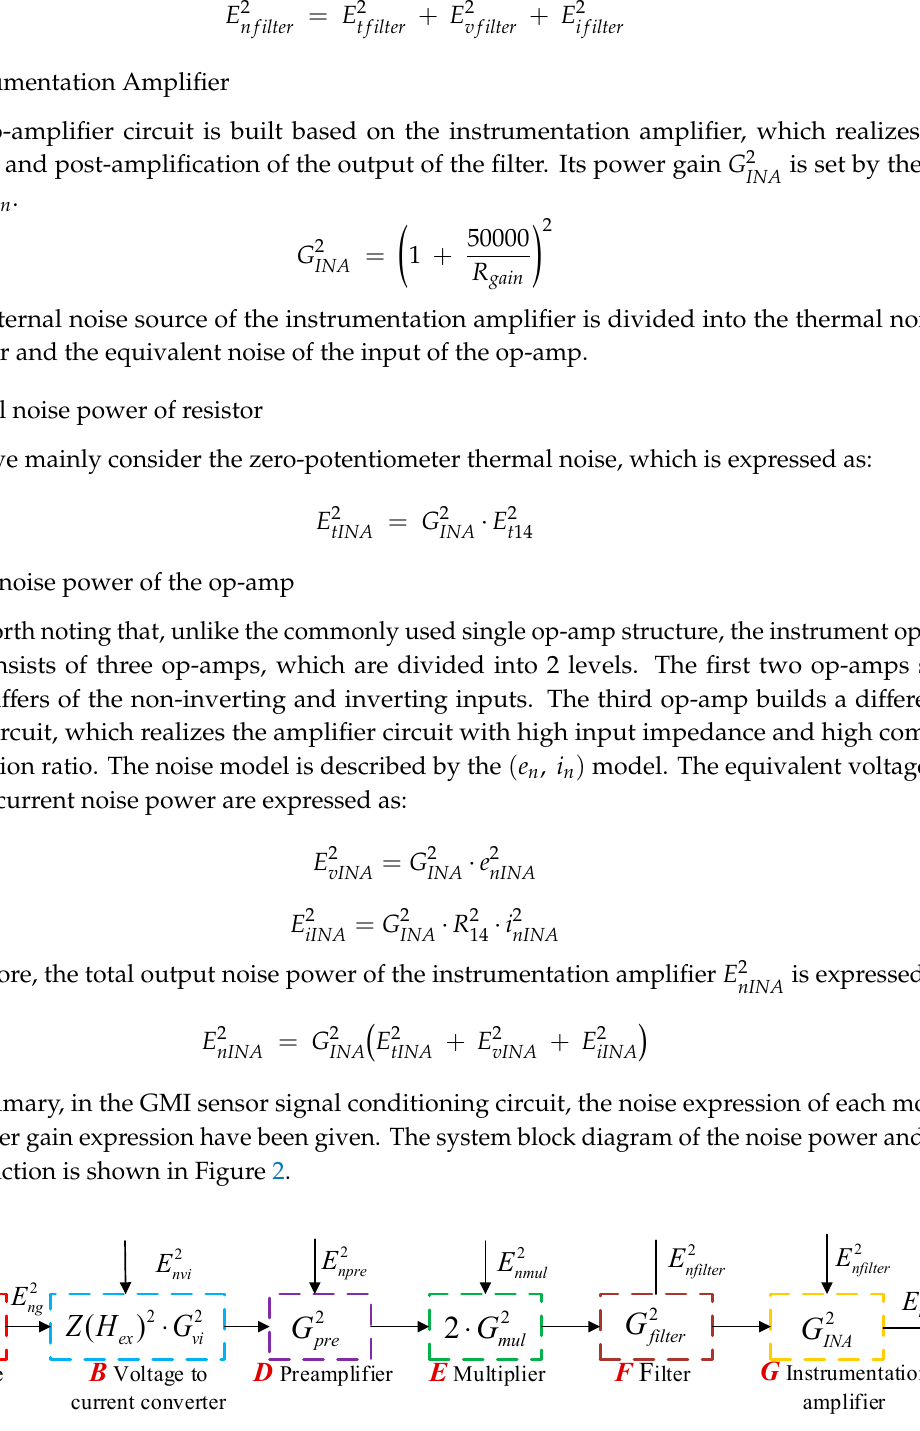
Figure 2. System block diagram of power gain transfer function.